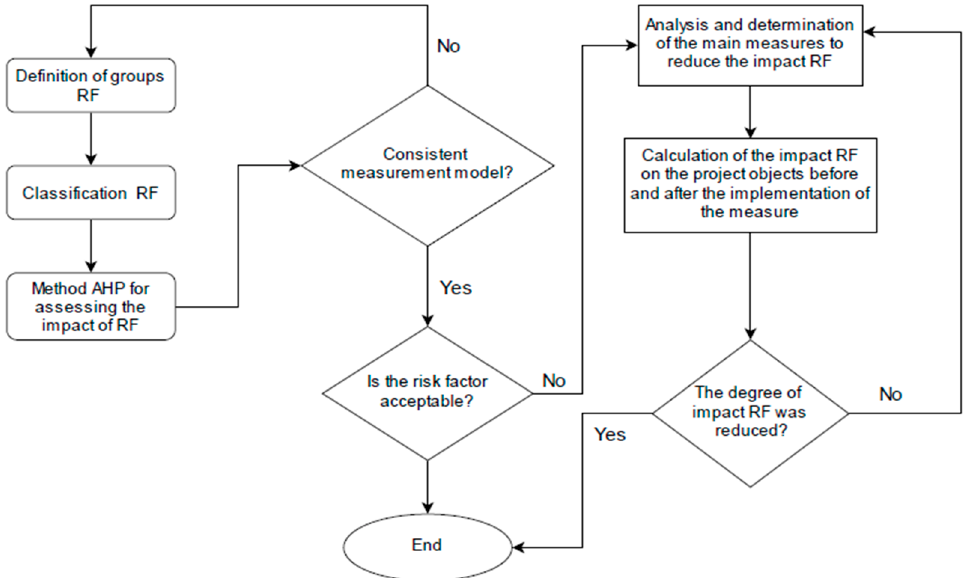
Figure 2. Algorithm of the practical stages of the study.